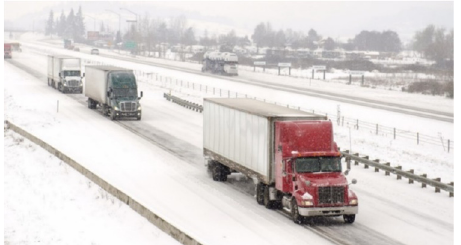
Figure 1 An illustration of Wyoming I-80 under winter adverse weather condition (Mack,